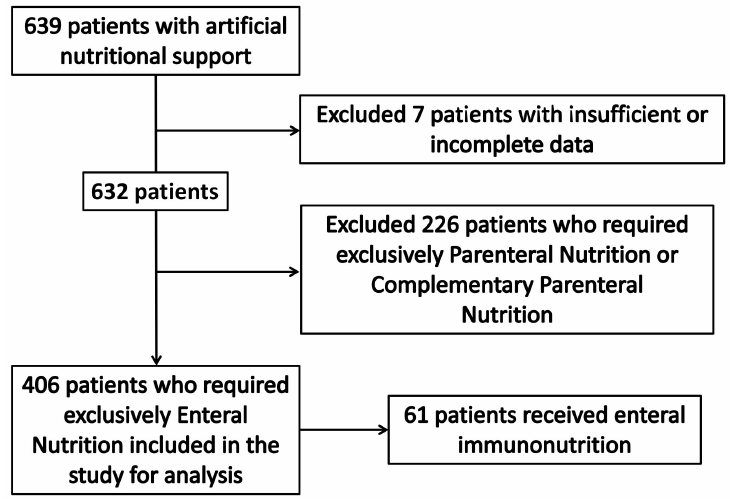
Figure 1. Study flow of patients included in the